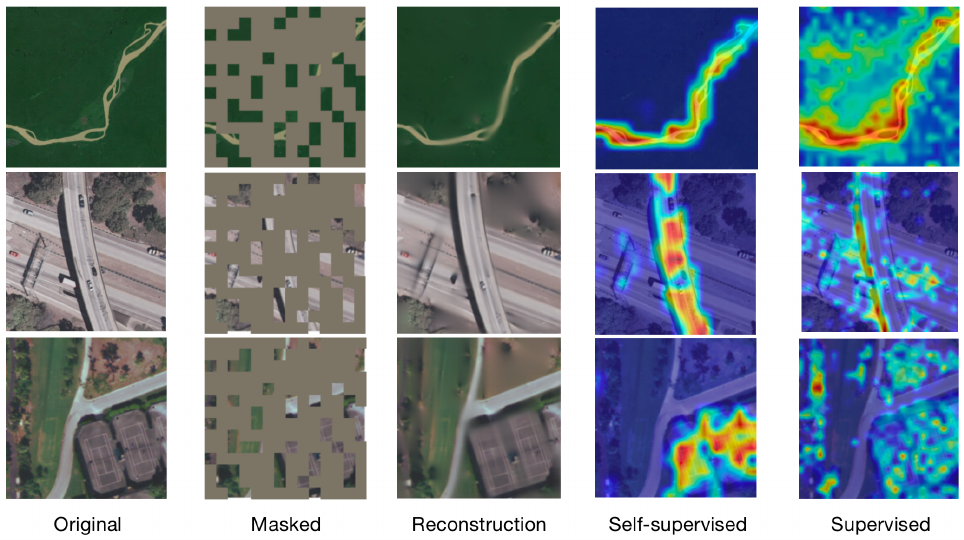
Figure 1. Some remote sensing images. The categories for each row, from top to bottom, are “river”, “overpass”, and “tennis court.” The images of each category have been processed multiple times, and each row from left to right represents the original image, the image after the mask operation, the image reconstructed using the MIM method, the visualization of self-supervised classification results, and the visualization of fully supervised classification